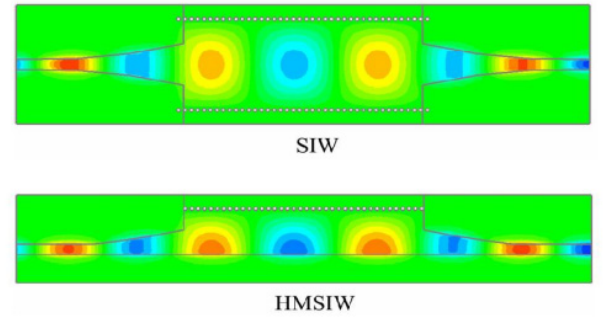
Figure 3. Field distribution in SIW and HMSIW [17].